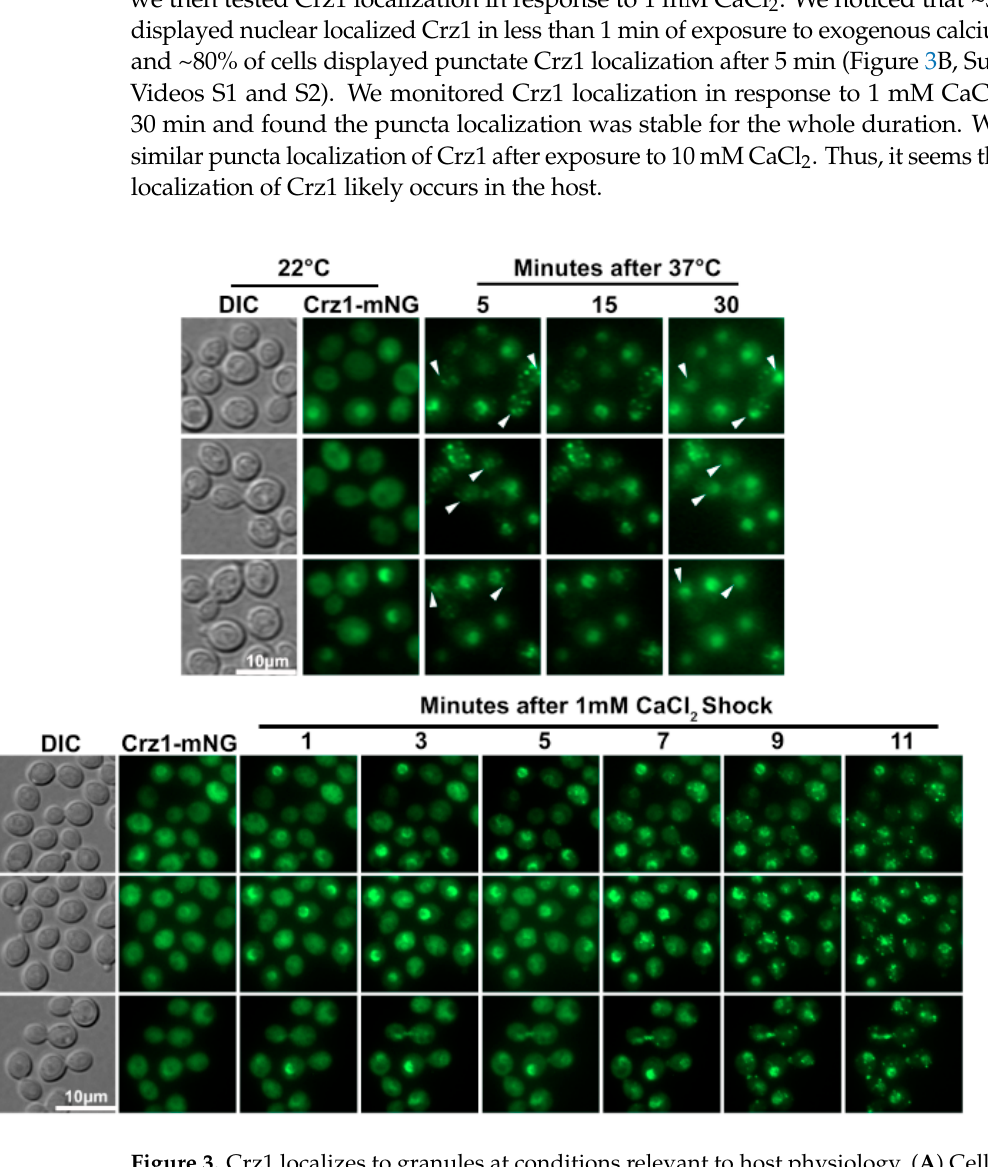
Figure 3. Crz1 localizes to granules at conditions relevant to host physiology. ( A ) Cells expressing Crz1-mNeonGreen were initially grown overnight at 22 °C. The cells were then prepared for mi- croscopy on a 37 °C pre-heated glass slide and examined on a microscope equipped with a heated stage set to 37 °C. White arrowheads indicate examples of cells where Crz1 localized to granules first before typical nuclear localization in response to 37 °C. ( B ) The same cells grown overnight at 22 °C were suspended in 1 mM CaCl 2 on a microscope slide and immediately imaged (Crz1-mNG). Images were taken of the same field of view at the indicated times. The scale is the same for all images in the same panel.